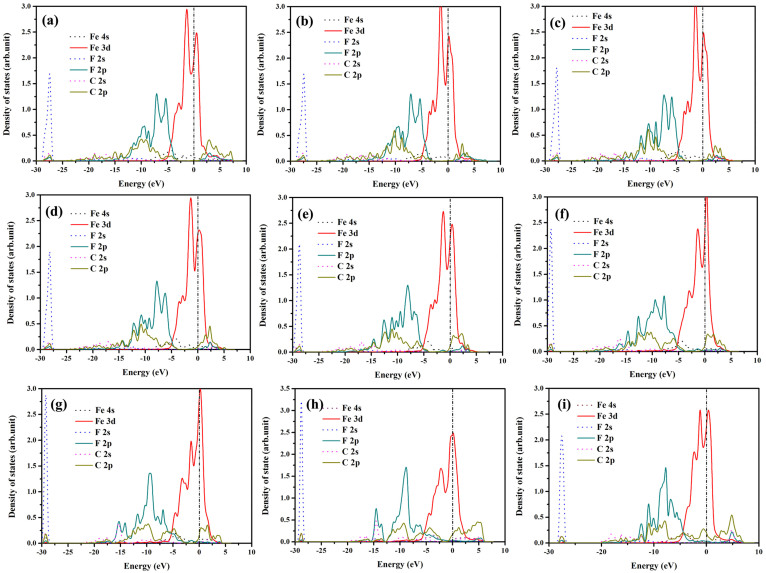
The density of states of Fe/FTD system under different strain∈, (a) 0, (b) −0.02, (c) −0.05, (d) −0.1, (e) −0.15, (f) −0.2, (g) −0.25, (h) −0.3, (i) −0.35.Fermi energy level EF = 0 eV.